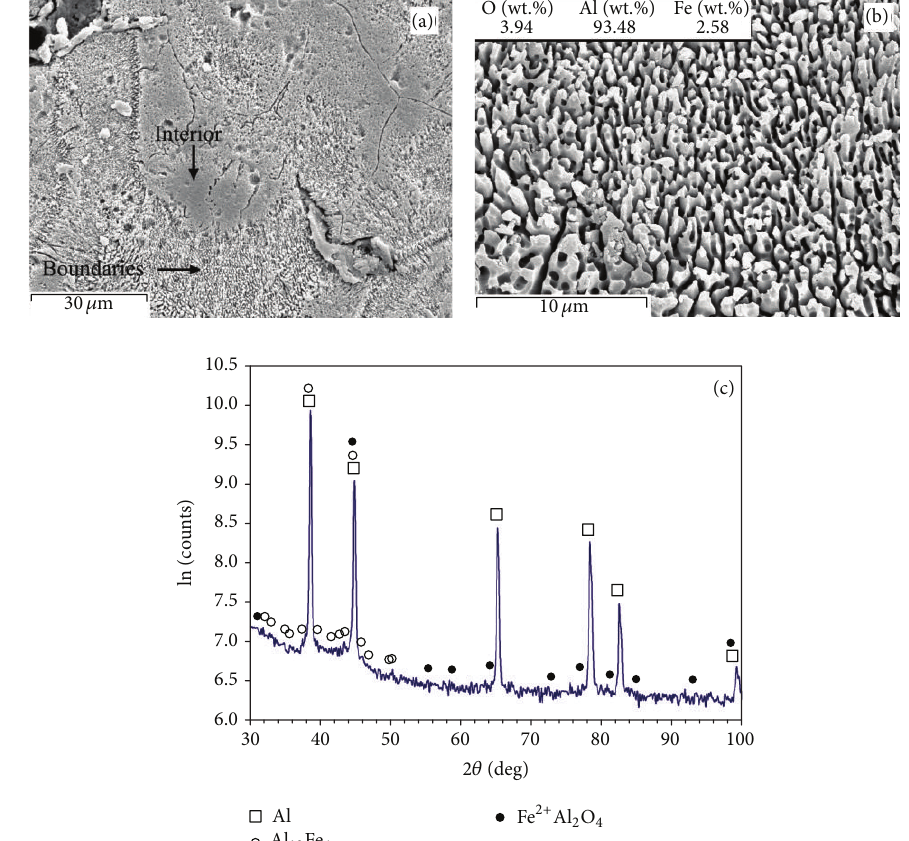
Figure 4: (a) Overall view of microstructure, (b) higher magnification of coralline-like and fuzzy appearance of boundaries in the previous image, and (c) XRD pattern of the SLM part fabricated when 𝑃 = 39 W, V = 0.5 m/s, and 𝑡 = 75 𝜇